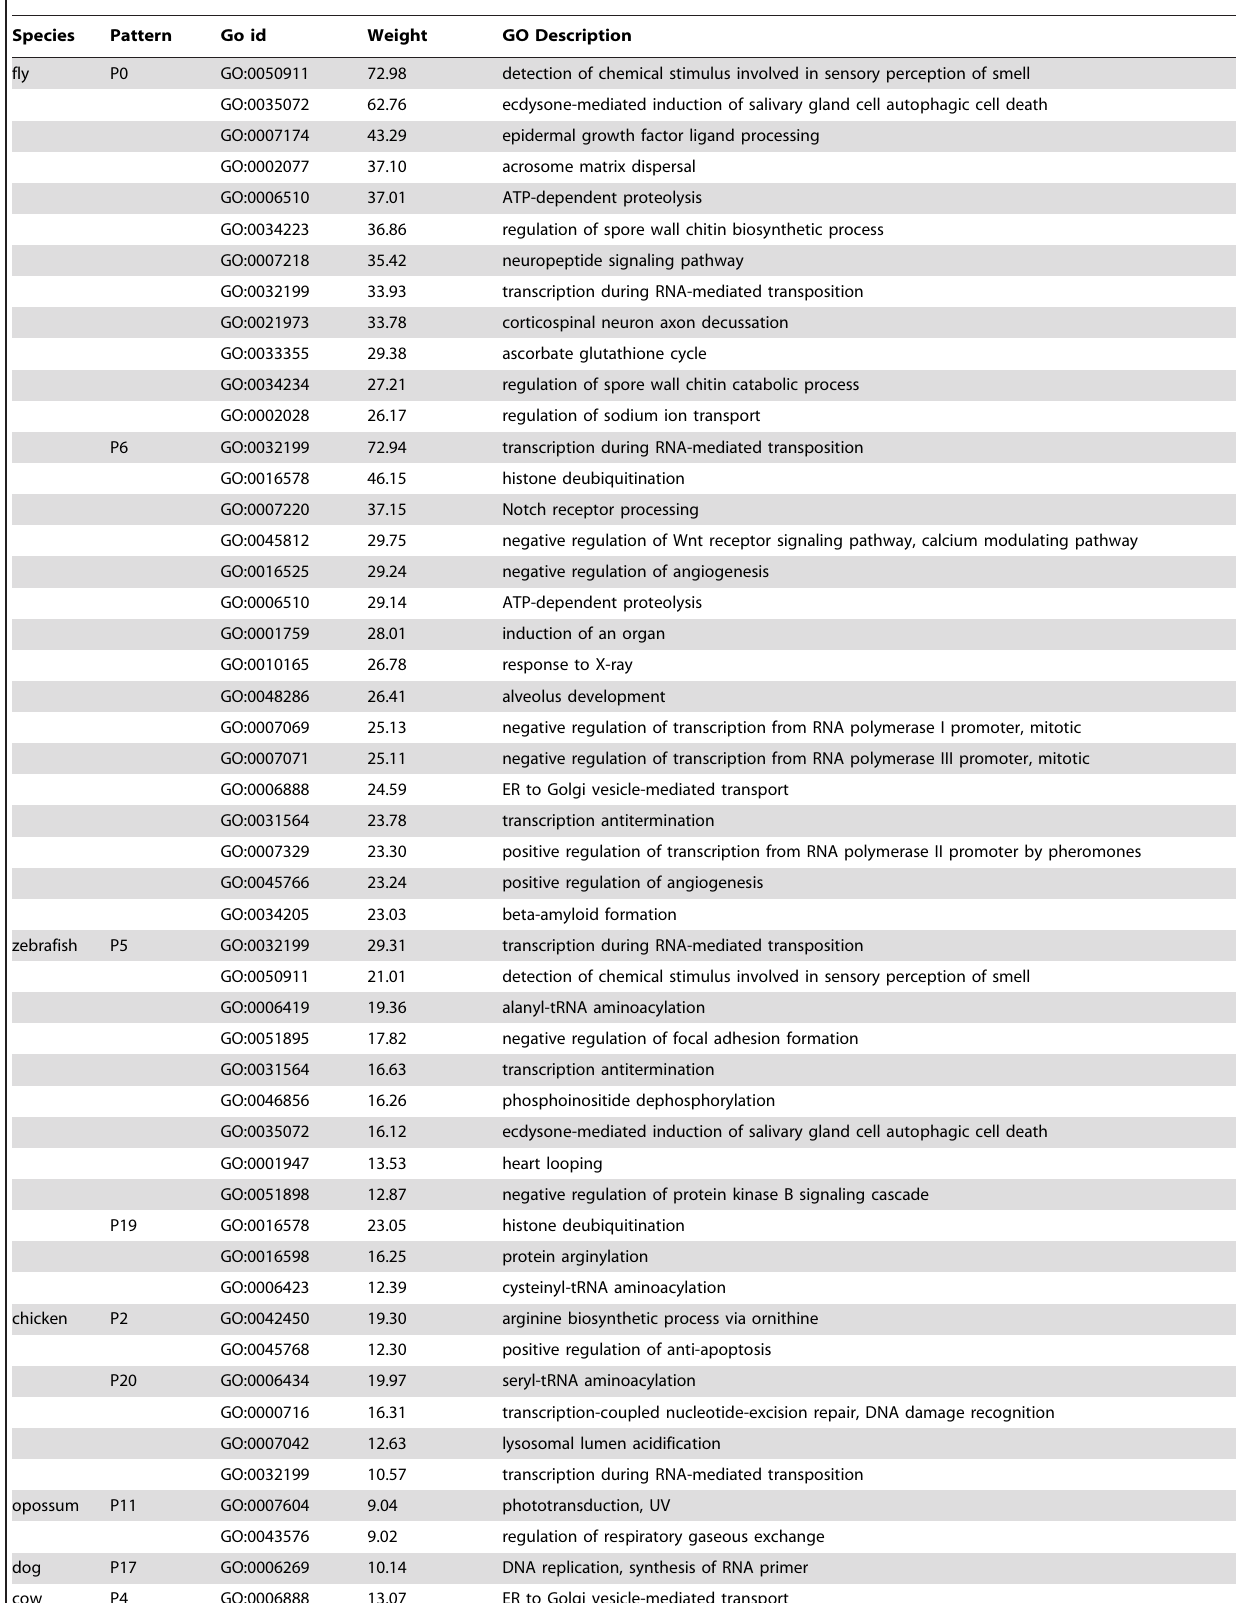
Table 4. Top species-specific annotations (BP).